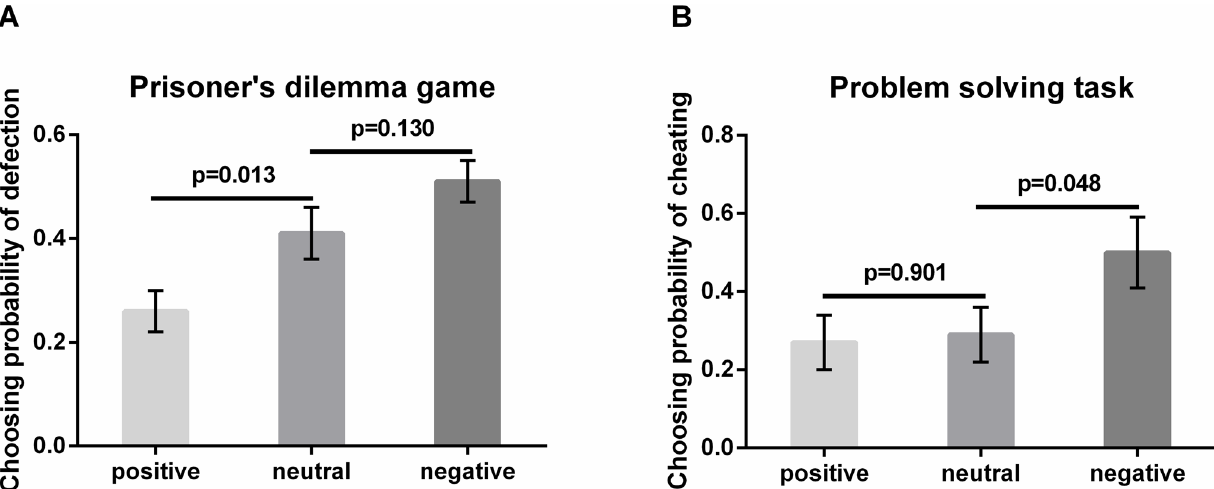
Fig 2. The behavioral results. (A). Choice probability of choosing defection (Experiment 1) in positive, neutral and negative social news conditions. (B). Choice probability of choosing cheating (Experiment 2) in positive, neutral and negative social news conditions. Note: Error bars represent standard errors of the mean.